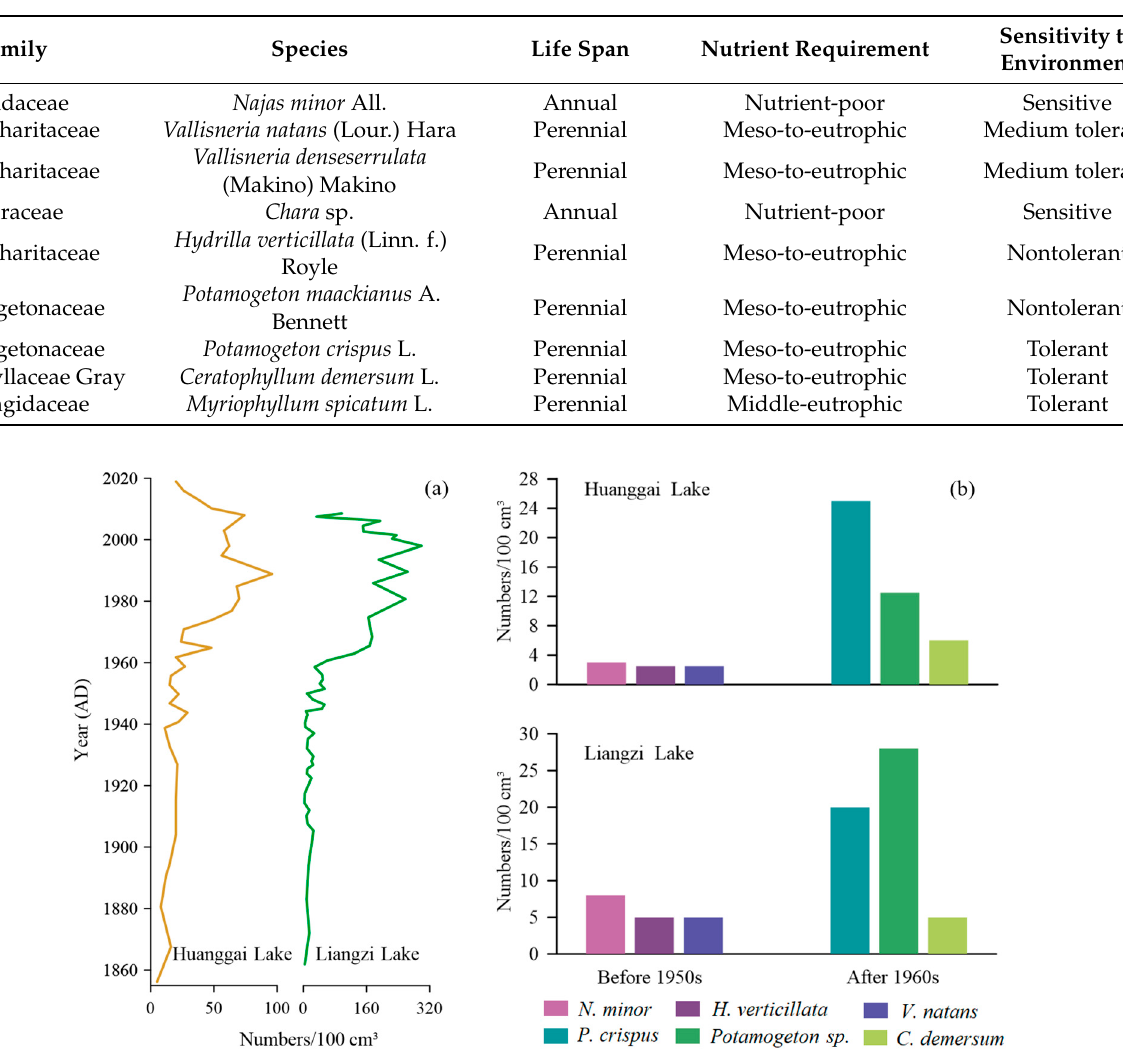
Table 2. Main aquatic plant groups and their ecological characteristics [31,37] in Huanggai Lake.